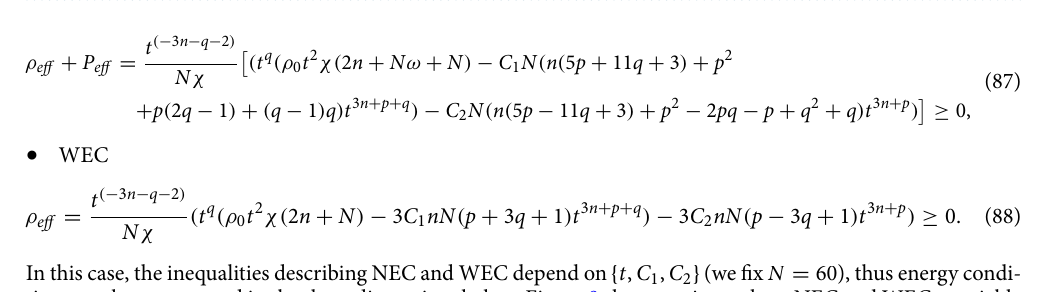
Figure 9. Regions where NEC and WEC are accomplished for power law